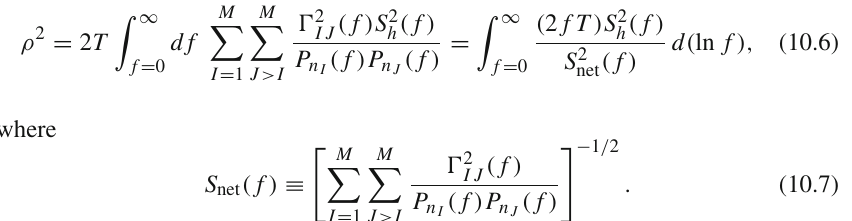
the frequency, which yield the characteristic strain for the signal, h c ( f ) , as well as for the noise, h n ( f ) . Examples of characteristic strain sensitivity curves are shown in Fig.